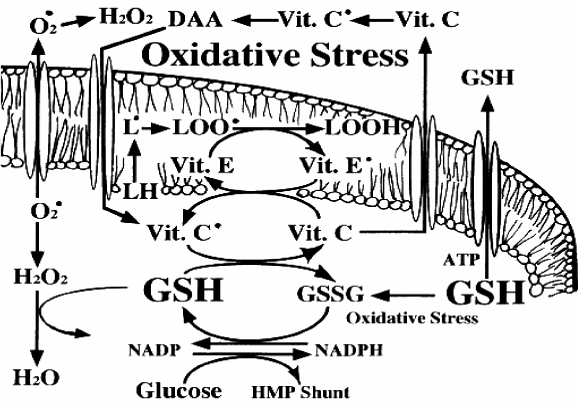
Figure 3. The role of vitamin C and E in inhibiting lipid peroxidation due to free radicals (Inoue M. 2001)